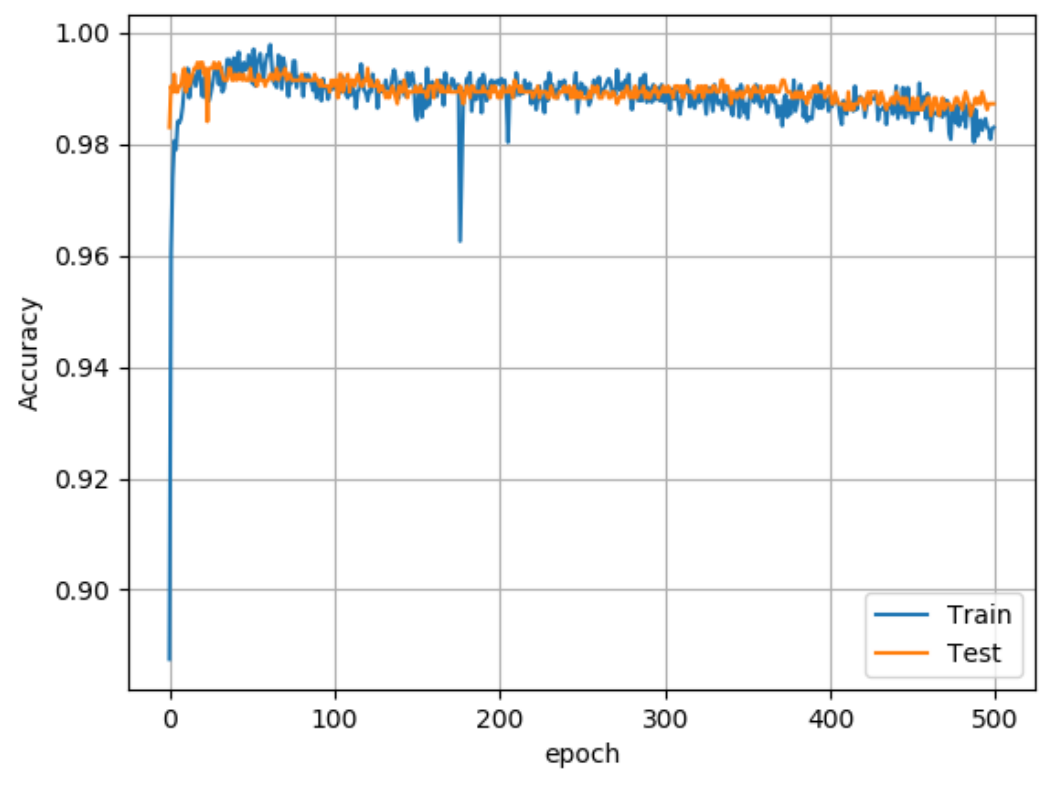
Figure 6. Accuracy of MLP Model.